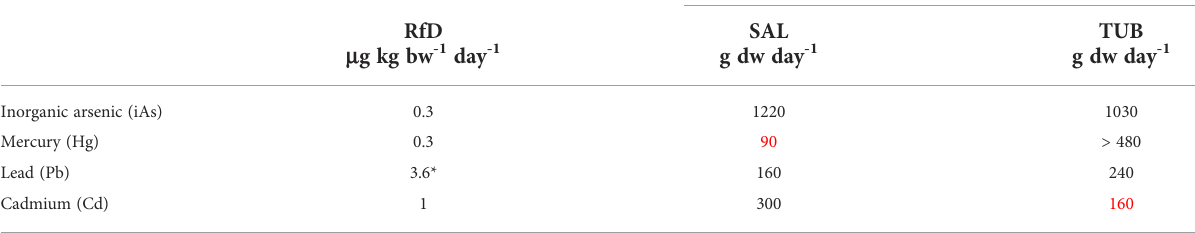
TABLE 4 Exposure assessment indicating how much dried biomass of Ulva fenestrata cultivated in the two herring production process waters salt brine (SAL) and tub water (TUB) that can be consumed before exceeding the reference dose (RfD) for each heavy metal, as indicated by the US Environmental Protection Agency (US EPA,